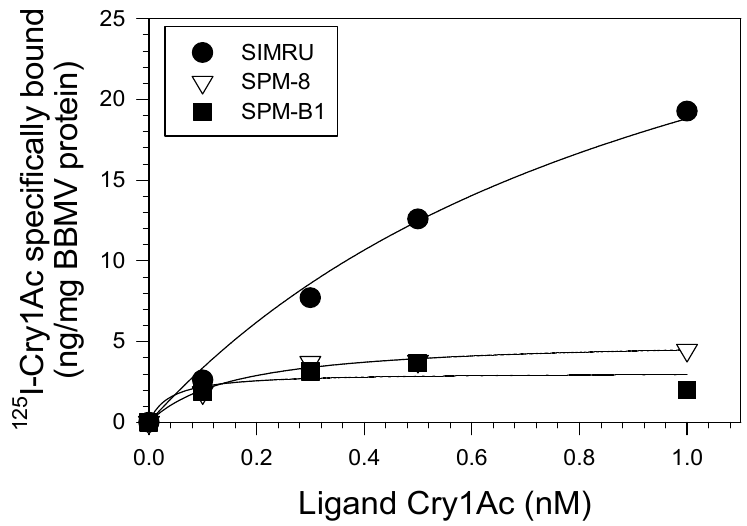
Figure 3. Saturation Cry1Ac -binding assays with midgut brush border membrane vesicles (BBMV) from larvae of wild type (SIMRU) and gene-edited (SPM-8 and SPM-B1) strains of Helicoverpa zea . Data points shown are the specific binding estimated from total and non-specific binding (as detailed in Materials and Methods) from two independent experiments each performed in duplicate. Curves are the result from non-linear regression fitting of the data to a one-site binding model as the best fit. Table 4. Binding parameters from saturation Cry1Ac binding assays and goodness of fit criteria for wild type (SIMRU) and gene edited (SPM-8 and SPM-B1) strains of Helicoverpa zea . K d = dissociation constant (in nM units); B max = concentration of receptors (in ng/mg BBMV protein units); SE = standard error; P = statistic for the parameter estimate (significant estimates ( p < 0.05) are underlined); R 2 = coefficient of determination for the regression model used for fitting (one binding site model).